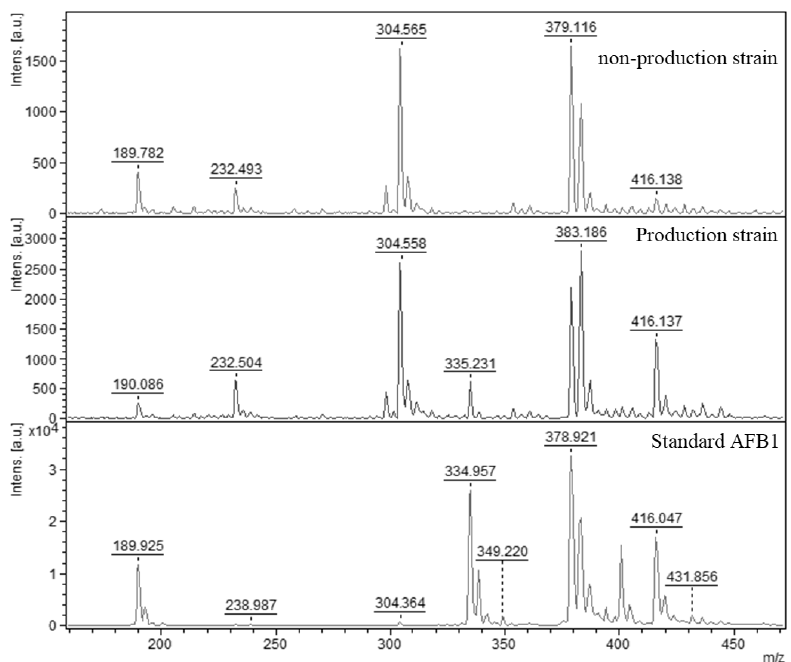
Figure 3. MALDI-TOF mass spectra of AFB 1 obtained by isolation from Aspergillus flavus mycelia. Standard AFB 1 (334.957 m/z), non-producing strain (peak absent) and producing strain with the Standard AFB 1 (334.957 m / z ), non-producing strain (peak absent) and producing strain with the peak peak (335.231 m/z). (335.231 m / z